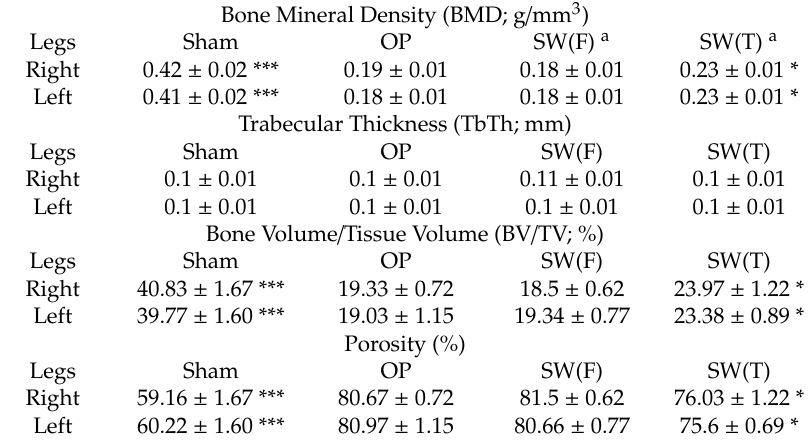
Table 3. Both VOI regions of the right and left femurs for BMD, TbTh, BV / TV, and porosity of OVX rats in the Sham, OP, SW(F), and SW(T) groups by micro-CT analysis. Bone Mineral Density (BMD; g / mm 3